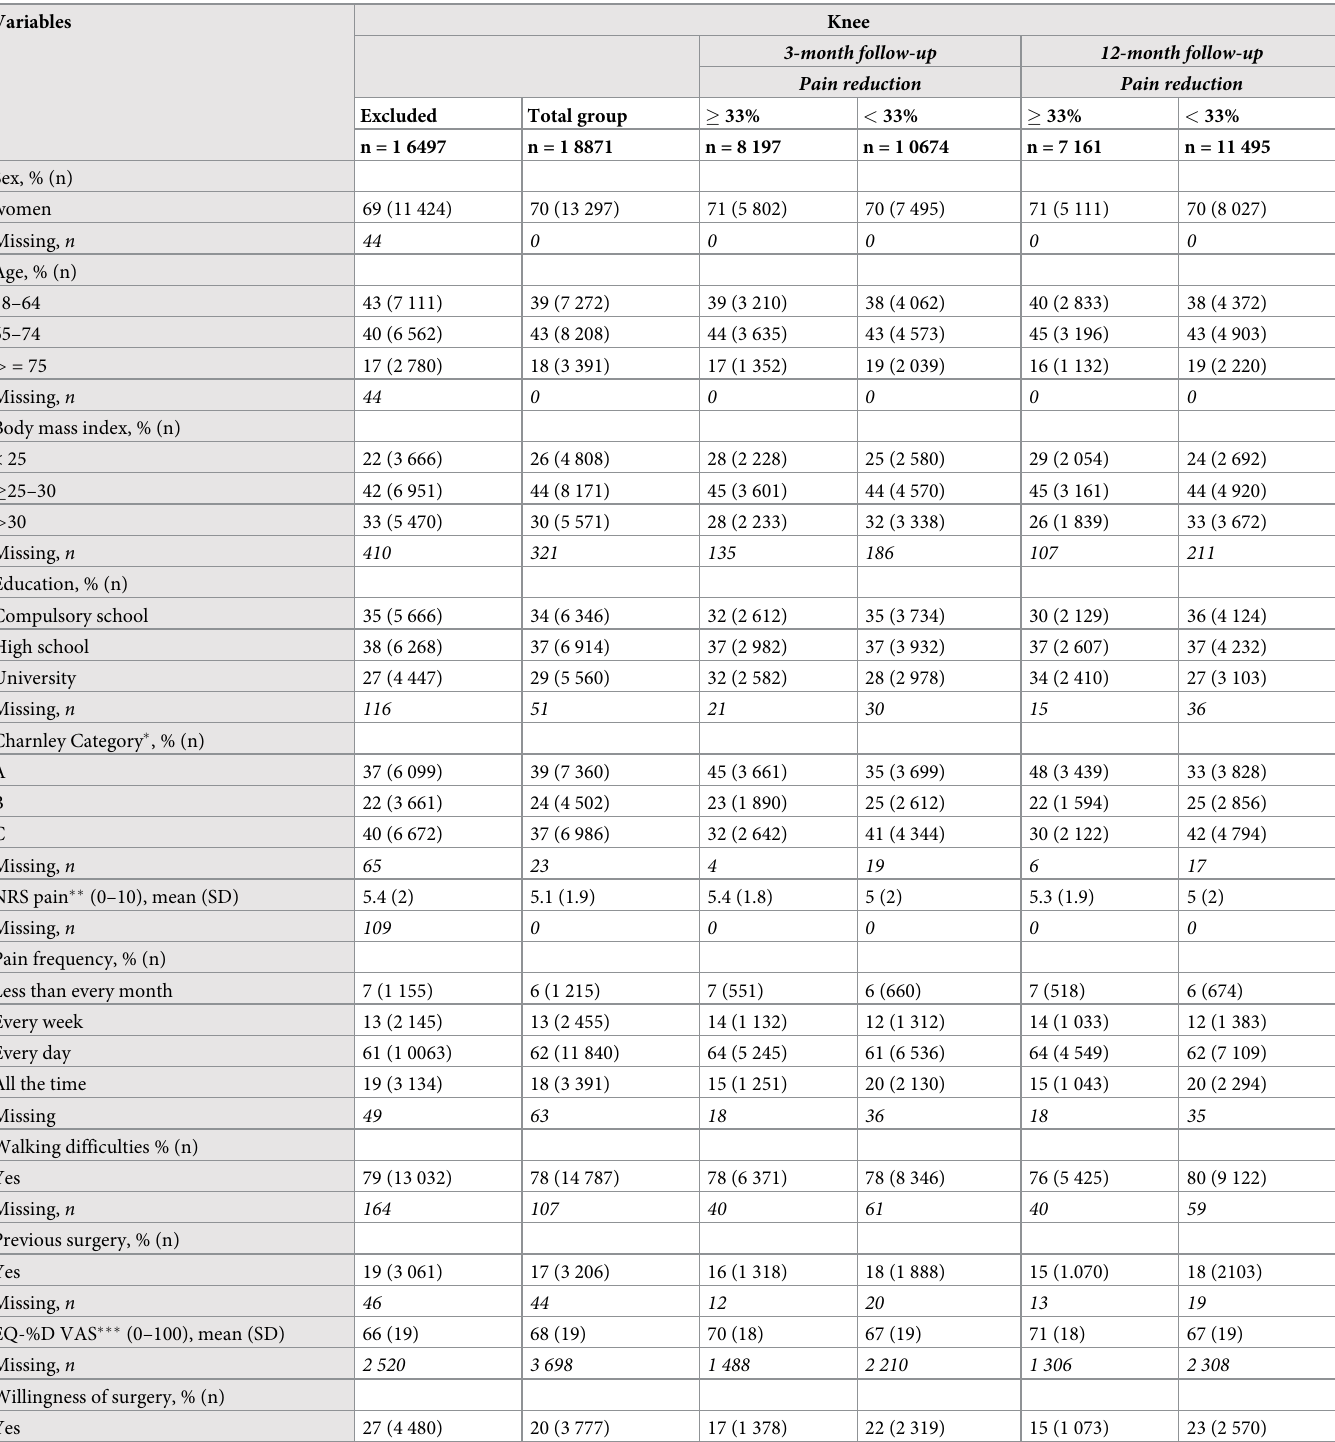
Table 1. Characteristics of patients with knee OA population (n =